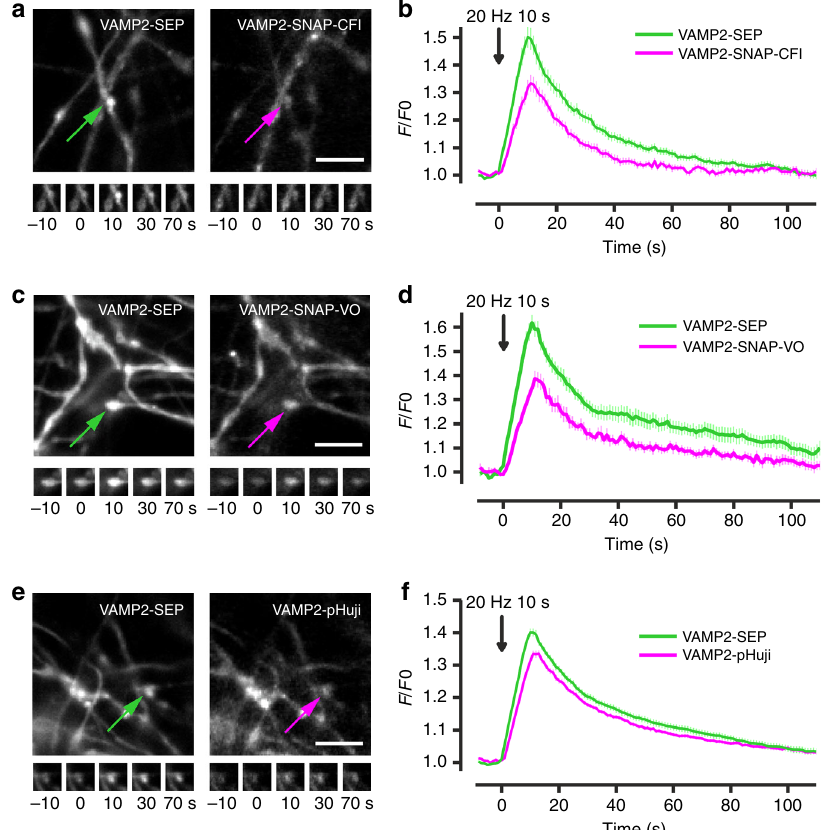
Fig. 3 Detection of synaptic vesicle exocytosis and recycling in hippocampal neurons. a Fluorescence images of hippocampal axons expressing VAMP2-SEP and VAMP2-SNAP-CFl with the locations of vesicle fusion indicated with arrows (top); scale bar: 5 µ m. Time-lapse images of the exocytosis events (bottom). b Average VAMP2-SEP (green) and VAMP2-SNAP-CFl (magenta) fl uorescence signals in response to fi eld stimulation for 10 s at 20 Hz. Fluorescence decay constant after stimulation was not different between the two probes (VAMP2-SEP 17.8 ± 1.5 s, VAMP2-SNAP-CFl 15.6 ± 1.0 s, p = 0.27, n = 25, Student ’ s t -test). c Fluorescence images of hippocampal axons expressing VAMP2-SEP (left) and VAMP2-SNAP-VO (right) with the insets indicated with arrows (top). Time-lapse of the exocytosis events (bottom). Scale bar: 5 µ m. d Average VAMP2-SEP (green) and VAMP2-SNAP-VO (magenta) fl uorescence signals in response to fi eld stimulation for 10 s at 20 Hz. Fluorescence decay after stimulation was not different between the two probes (VAMP2-SEP 13.2 ± 1.7 s; VAMP2-SNAP-VO 13.0 ± 1.5 s, p = 0.51, n = 13, Student ’ s t -test). e Fluorescence images of hippocampal axons expressing VAMP2-SEP (left) and VAMP2-pHuji (right) with the insets indicated with arrows (top). Time-lapse of the exocytosis events (bottom). Scale bar: 5 µ m. f Average VAMP2-SEP (green) and VAMP2-pHuji (magenta) fl uorescence signals in response to fi eld stimulation for 10 s at 20 Hz. Fluorescence decay constant after stimulation was 16.2 ± 0.8 s for SEP and 19.6 ± 0.9 s for pHuji ( n = 60). Data are represented as mean ±